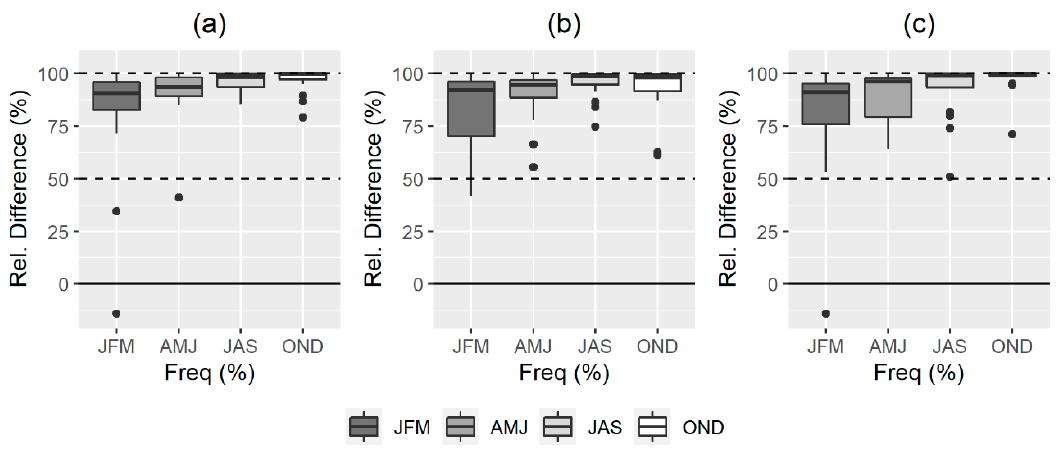
Figure 6. Percentage of reduction per season of flow for gauges ( a ) RD025 / 56610000, ( b ) RD029 / 56659998, and ( c ) RD031 / 56696000. JFM, January to March; AMJ, April to June; JAS, July to September; OND, October to December.